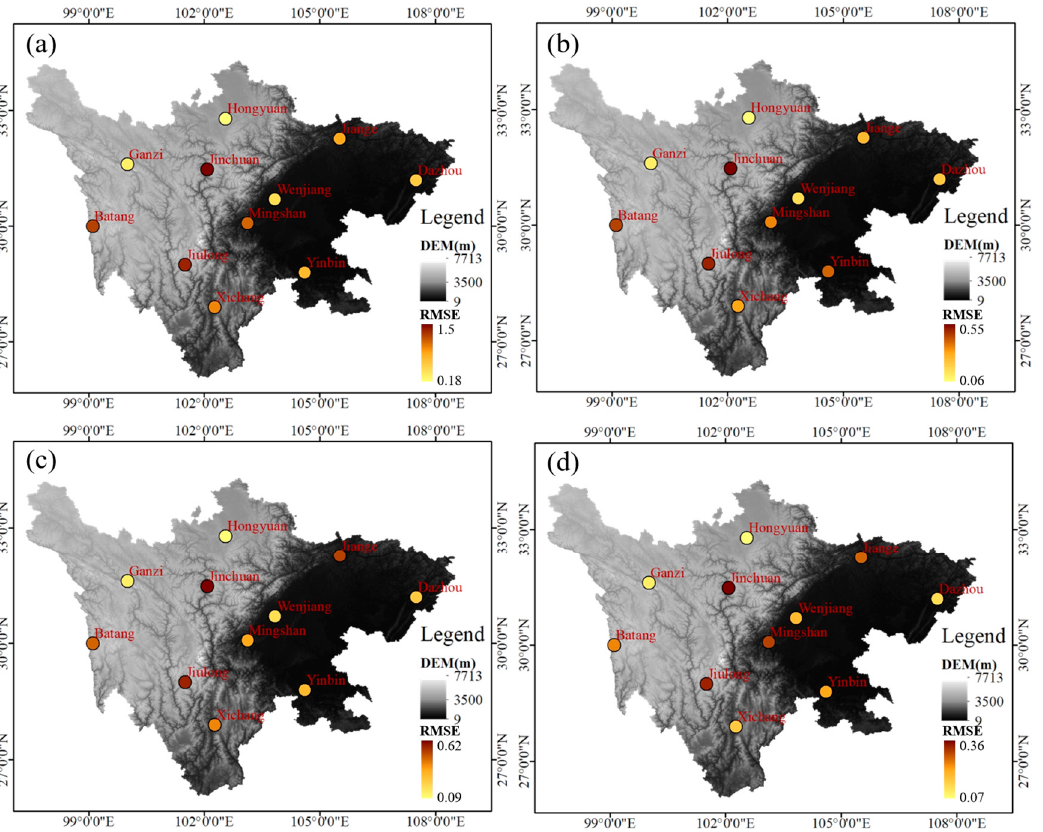
Figure 7. Spatial distribution of RMSE and DEM. ( a ) Whole layer; ( b ) high layer; ( c ) middle layer; ( d ) low layer.